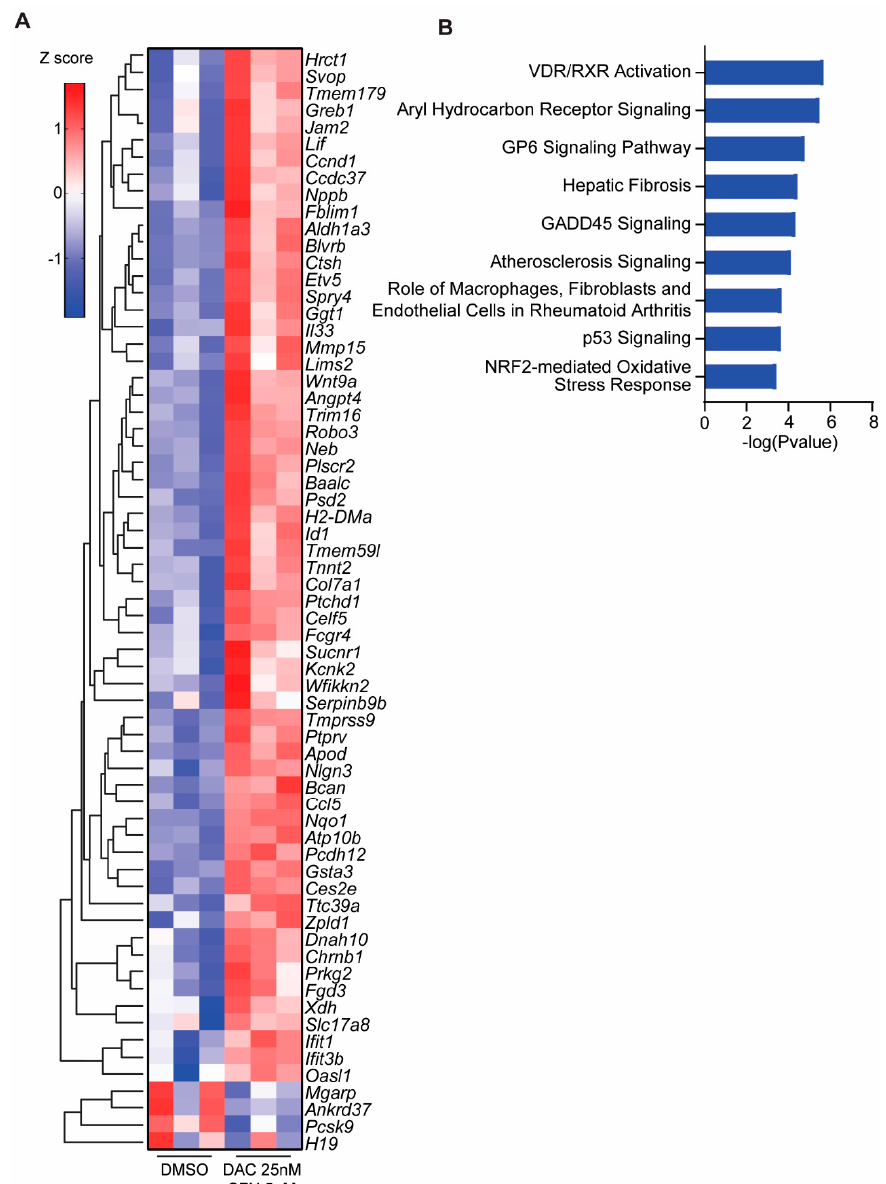
Figure 3. Differential gene expression induced by SFN and DAC combination treatment and the involved biological pathways. ( A ) Differentially expressed genes from the combination treatment of SFN and DAC compared to control treatments. Genes with greater than 3-fold change ( p < 0.001) were analyzed with unsupervised clustering (Z score shown in the color key). ( B ) Top canonical pathways from the combination treatment of SFN and DAC. Genes greater than 2-fold change than the control with the combination treatment of SFN and DAC were analyzed with IPA for their biological significance. The top nine pathways are shown here.